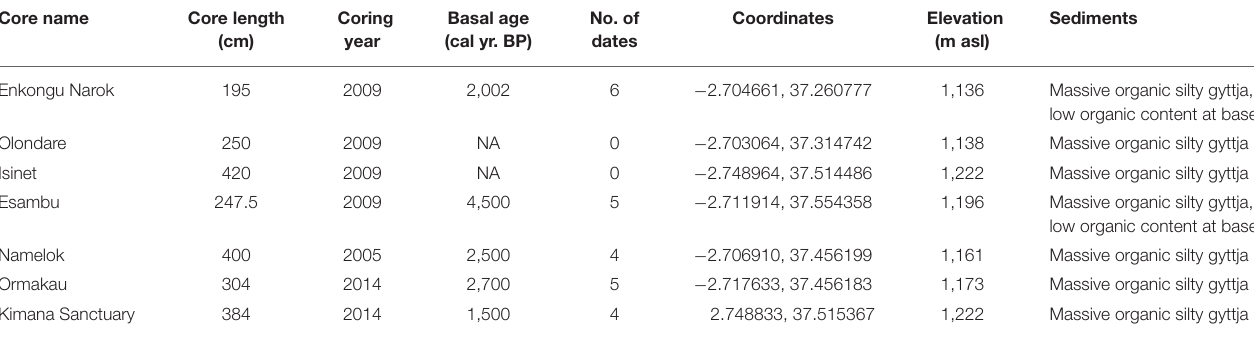
TABLE 3 | List of sediment cores collected from Amboseli wetlands using a hand-operated, D-shaped barrel (5cm diameter) Russian peat corer (Jowsey,